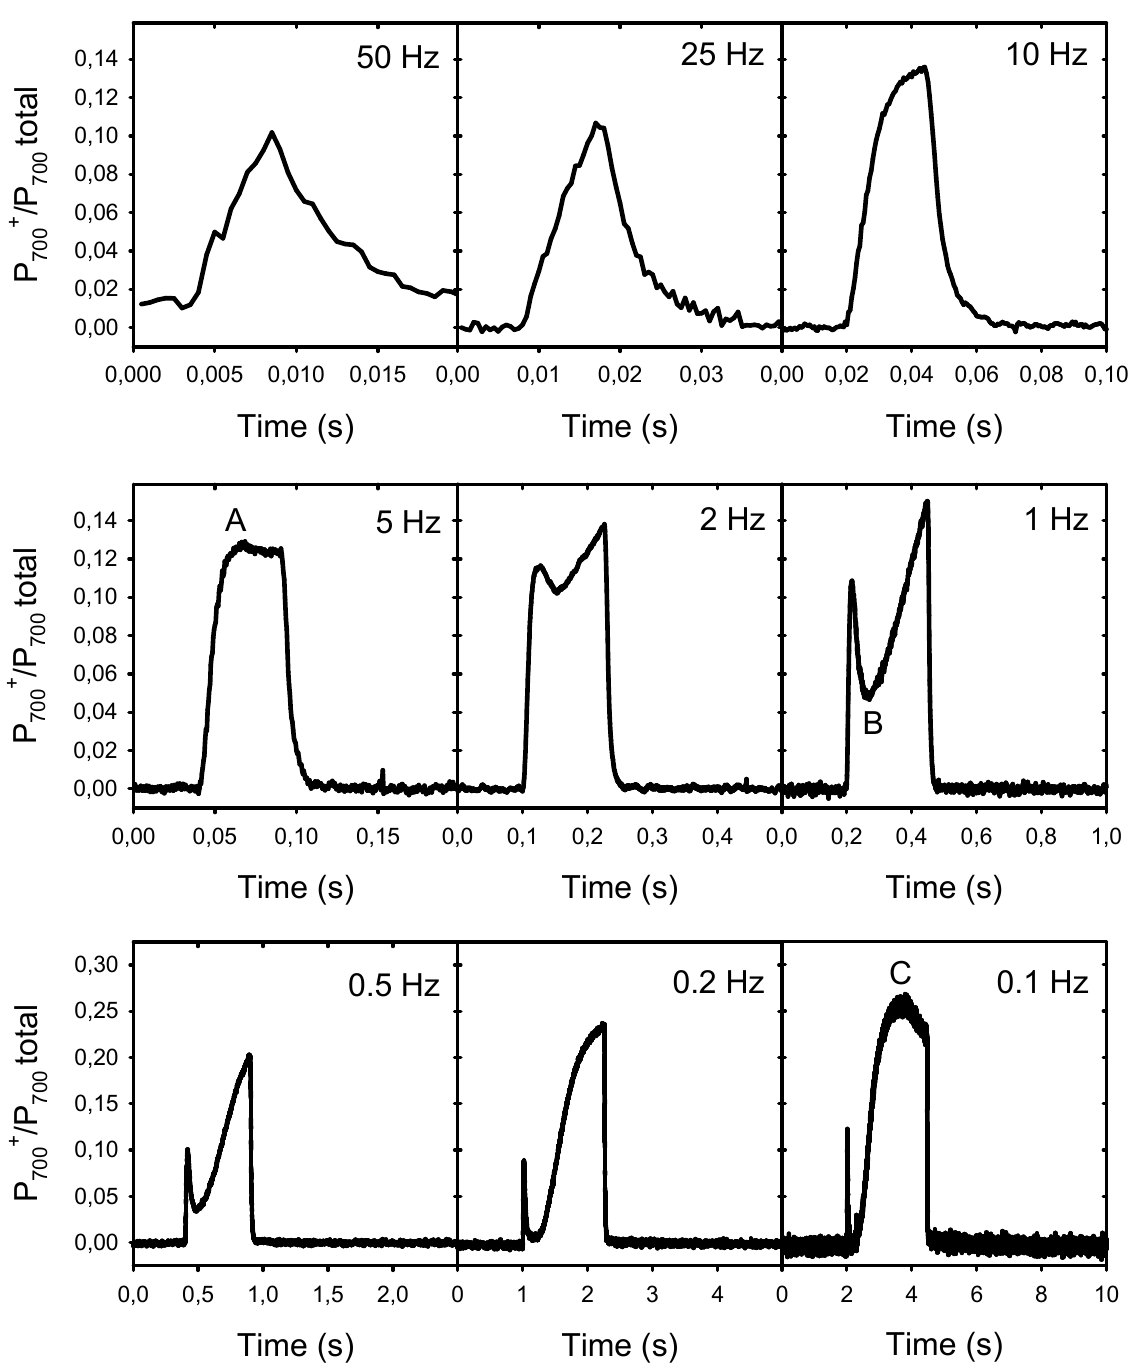
Figure 4. Kinetics of the P 700 redox changes during the light pulses of different frequencies. The kinetics represent the changes in the proportion of photooxidized P 700 (from 0 to 1) during one light cycle (25% light, 75% darkness). To facilitate their comparison, the timescales are different. The scales of the y -axes are the same for the two upper rows but a different scale was used for the lower row. The letters A, B, and C in the kinetics of 5 Hz, 1 Hz, and 0.1 Hz indicate the distinct phases of the typical kinetics of light-induced P 700 redox